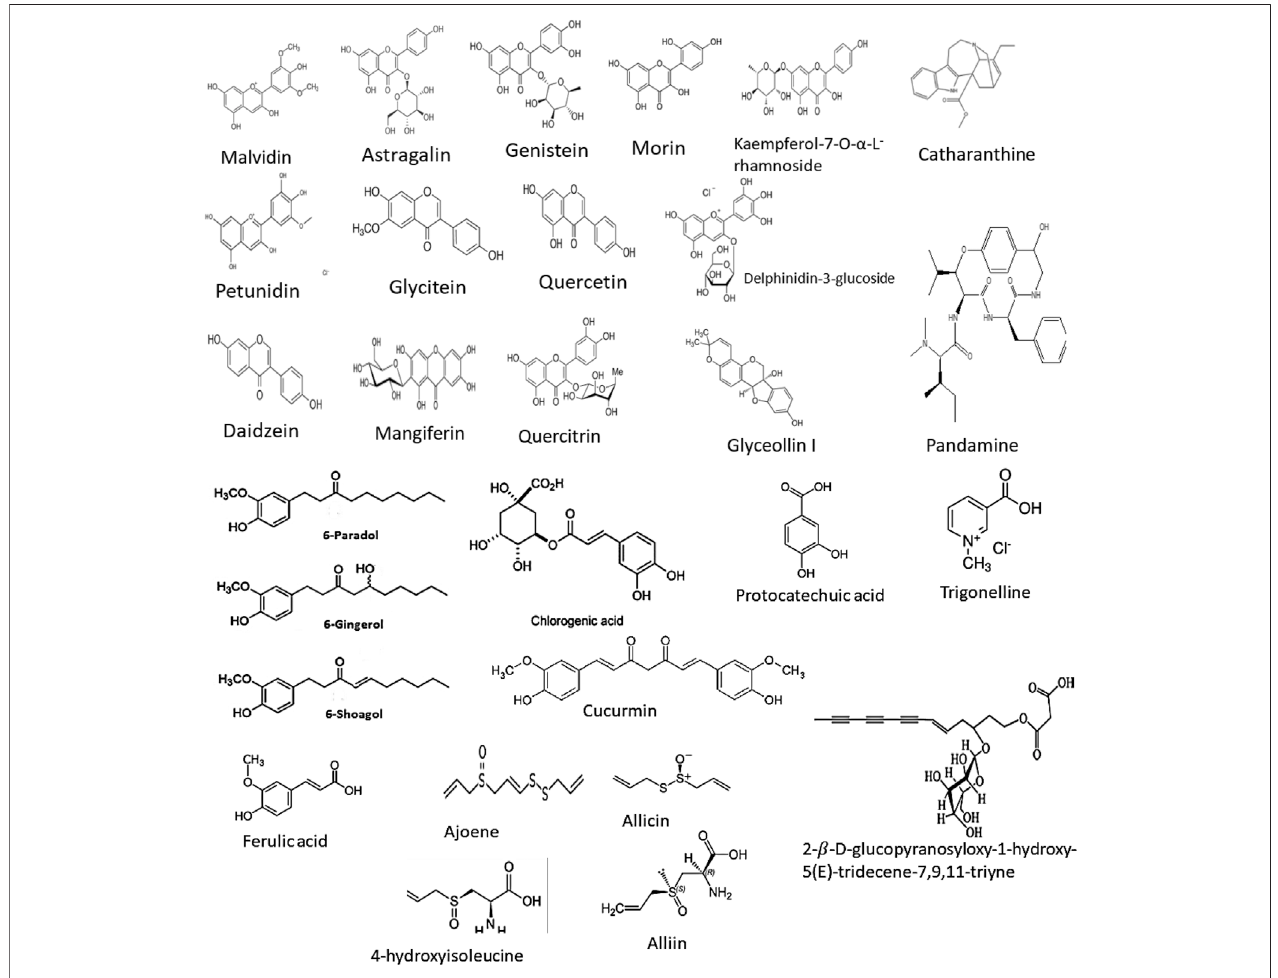
FIGURE 8 | Some bioactive components